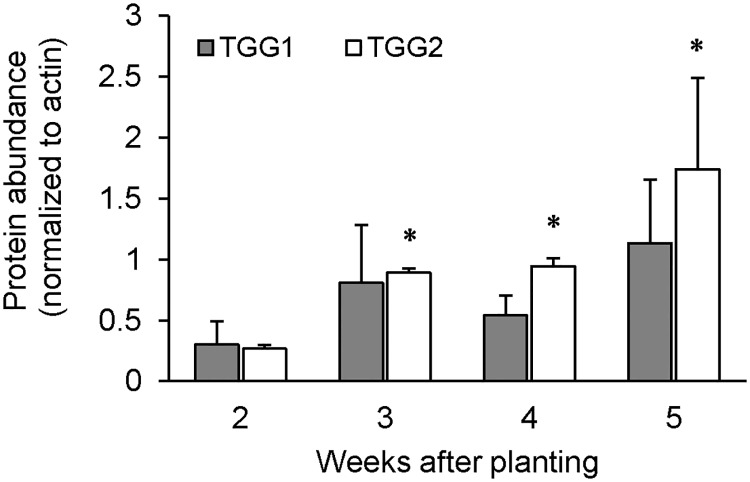
Protein abundance of TGG1 and TGG2 during development of A. thaliana plants grown under long-day conditions.Rosette leaves were harvested at the beginning of the light period and protein abundance was quantified after western-blotting and immunodetection using ImageJ. Asterics indicate significant differences (Student’s T-test; P < 0.01) compared to the protein abundance in two-week-old plants. Error bars indicate the standard deviation of two to three independent experiments with pools (2- and 3-week-old plants) and single plants (4- and 5-week-old plants).